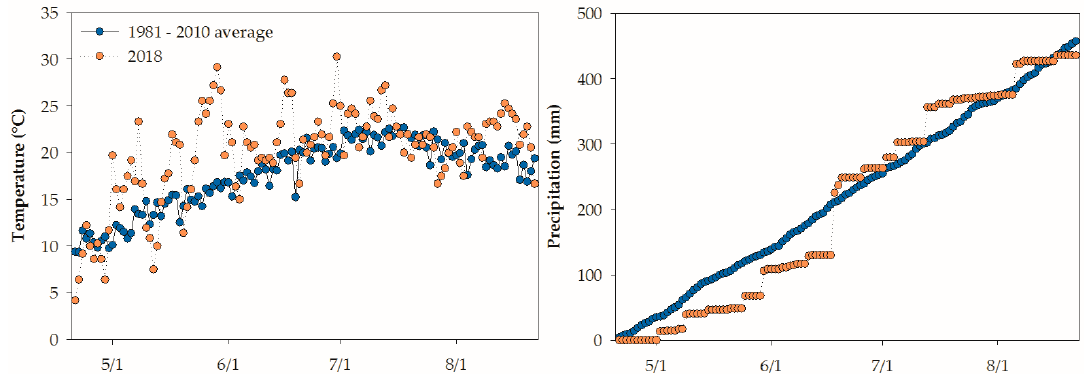
Figure 1. Daily average air temperature and cumulative precipitation from 20 April–22 August in 2018 and the 1981–2010 average.